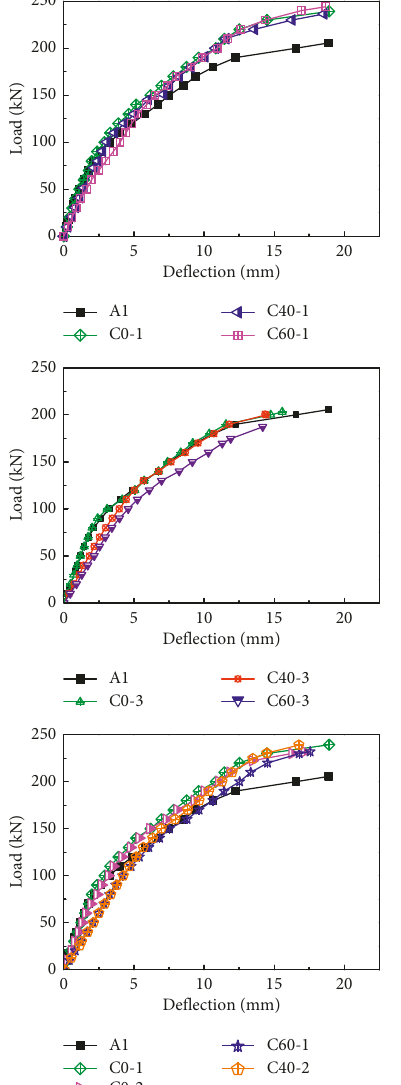
Figure 8: Load-deflection curves.